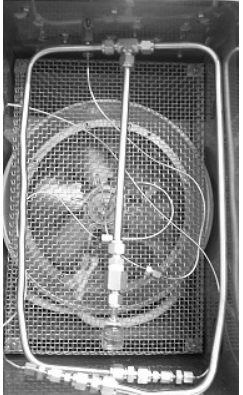
Figure 2. Schematic arrangement showing the internal close-up of RF-GC system